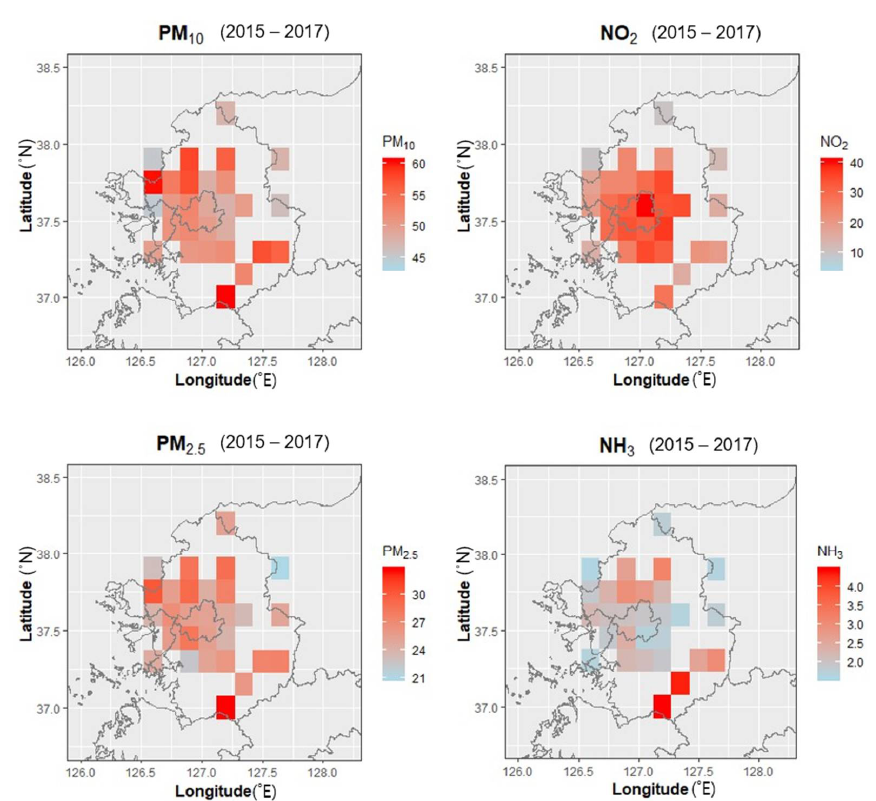
Figure 3. Average concentrations of PM 10 , PM 2.5 , NO 2 , and NH 3 in the Seoul Metropolitan Area (SMA) from 2015 to 2017 (units: PM 10 and PM 2.5 ( µ g/m 3 ); NO 2 and NH 3 (ppbv)). The colored area indicates an area where all the chemical species’ measurements are coincidently available.